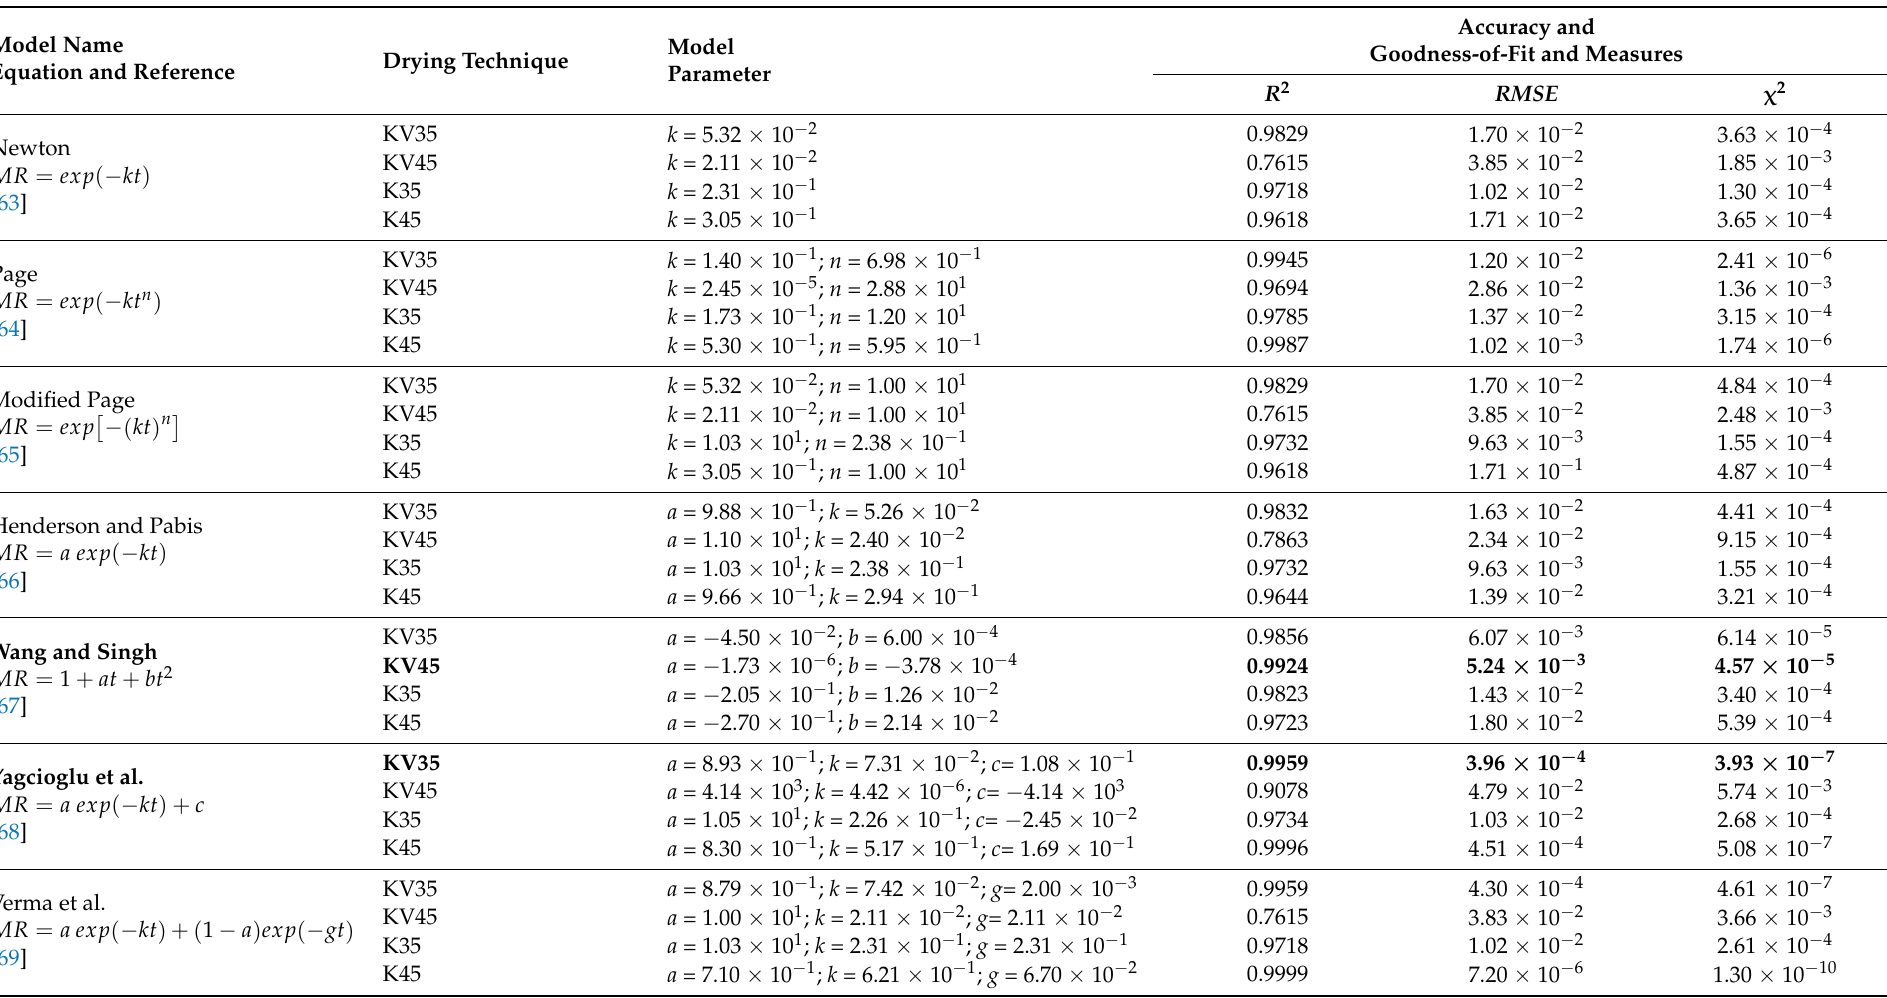
Table 6. Model parameters, accuracy and goodness-of-fit measures of the kinetic models used for Kurut samples by different drying